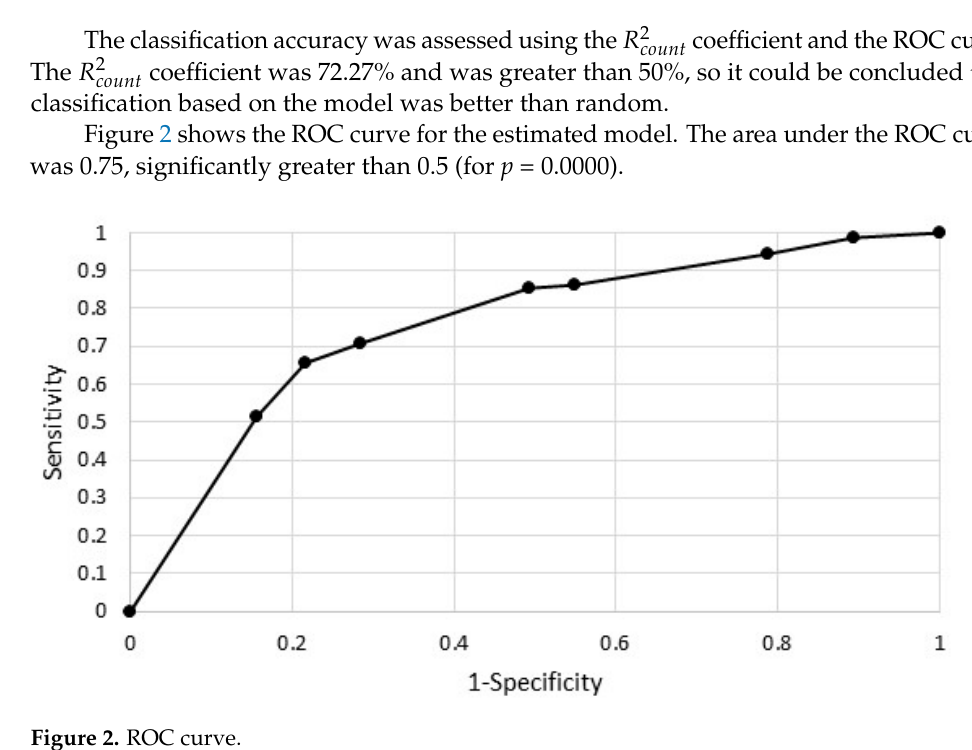
Table 6. Logit model parameter evaluations.